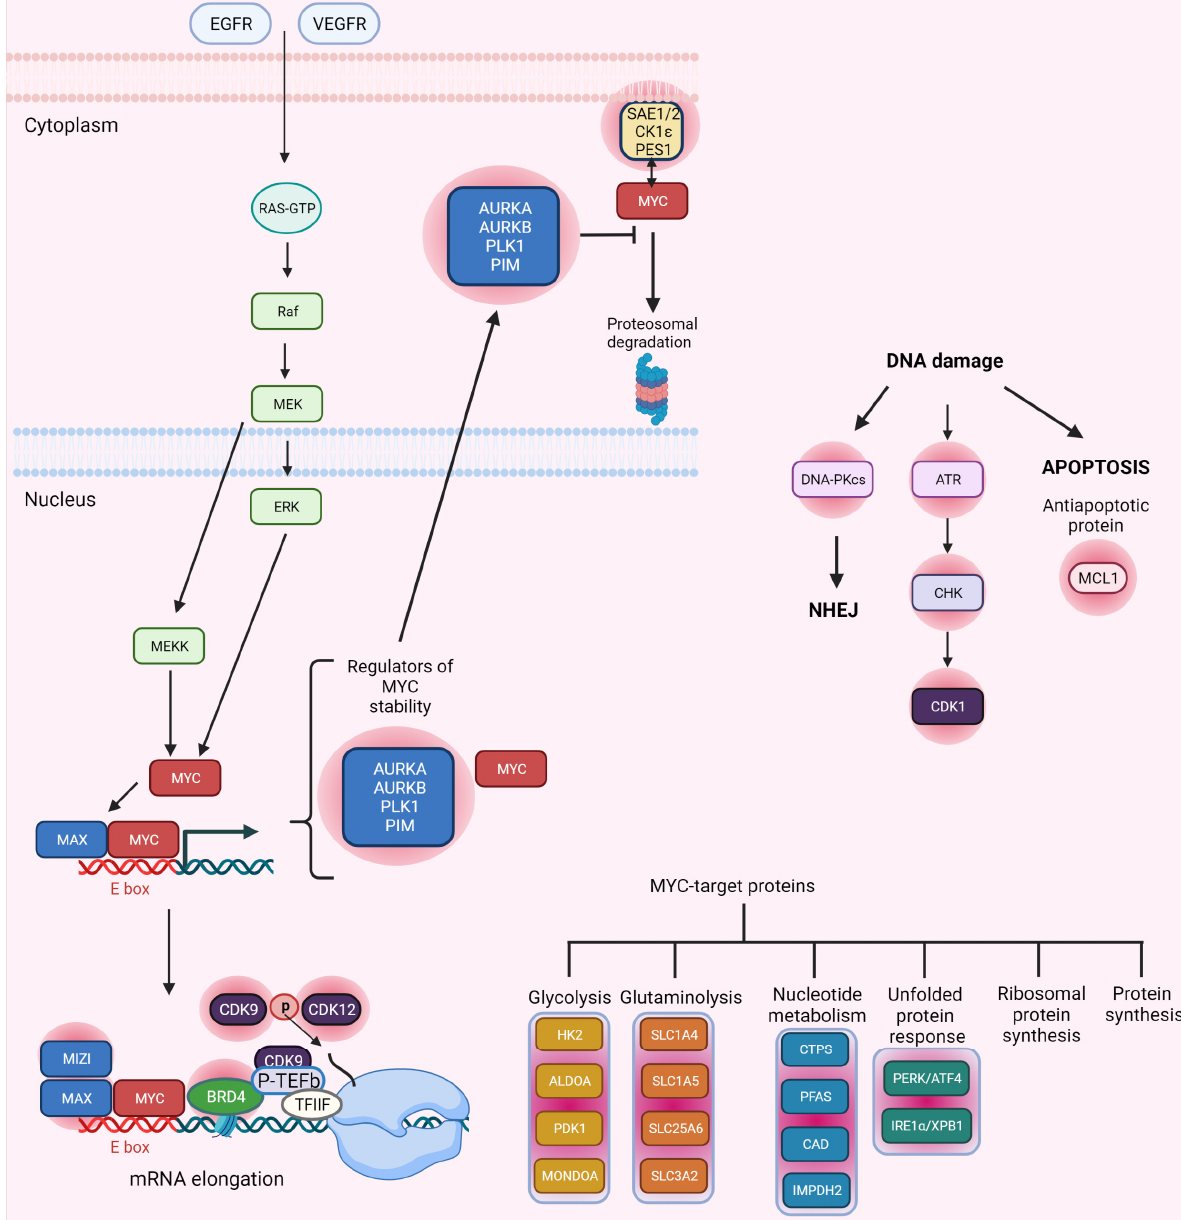
Figure 2. MYC-dependent control of gene expression and synthetic lethality partners of MYC. In response to mitogenic stimuli, the RAS-RAF-MEK-ERK pathway triggers MYC-dependent gene expression of enzymes involved in the control of glycolysis, glutaminolysis, nucleotide metabolism, unfolded protein response, general protein synthesis, and ribosomal protein synthesis, many of which were identified as synthetic lethality partners of MYC (indicated as pink shadows). For example, CDK9 and CDK12, which control the mRNA elongation by RNA polymerase II via phosphorylation of the CTD domain of the enzyme, were identified as MYC-SL partners. Regulators of MYC stability that prevent the proteasomal degradation of the protein, and four DDR components, namely ATR, CHK1, CDK1, and DNA-PKcs, also constitute a pool of MYC-SL partners. Based on [41,45,46]. Created with BioRender.com (accessed on 1 February